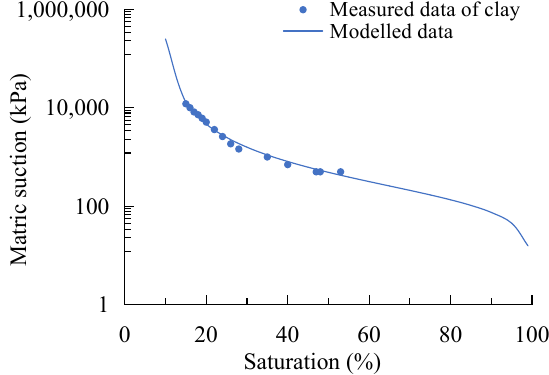
Figure 22. Soil–water characteristic curve based on experimental points [27] and the fitted curve.